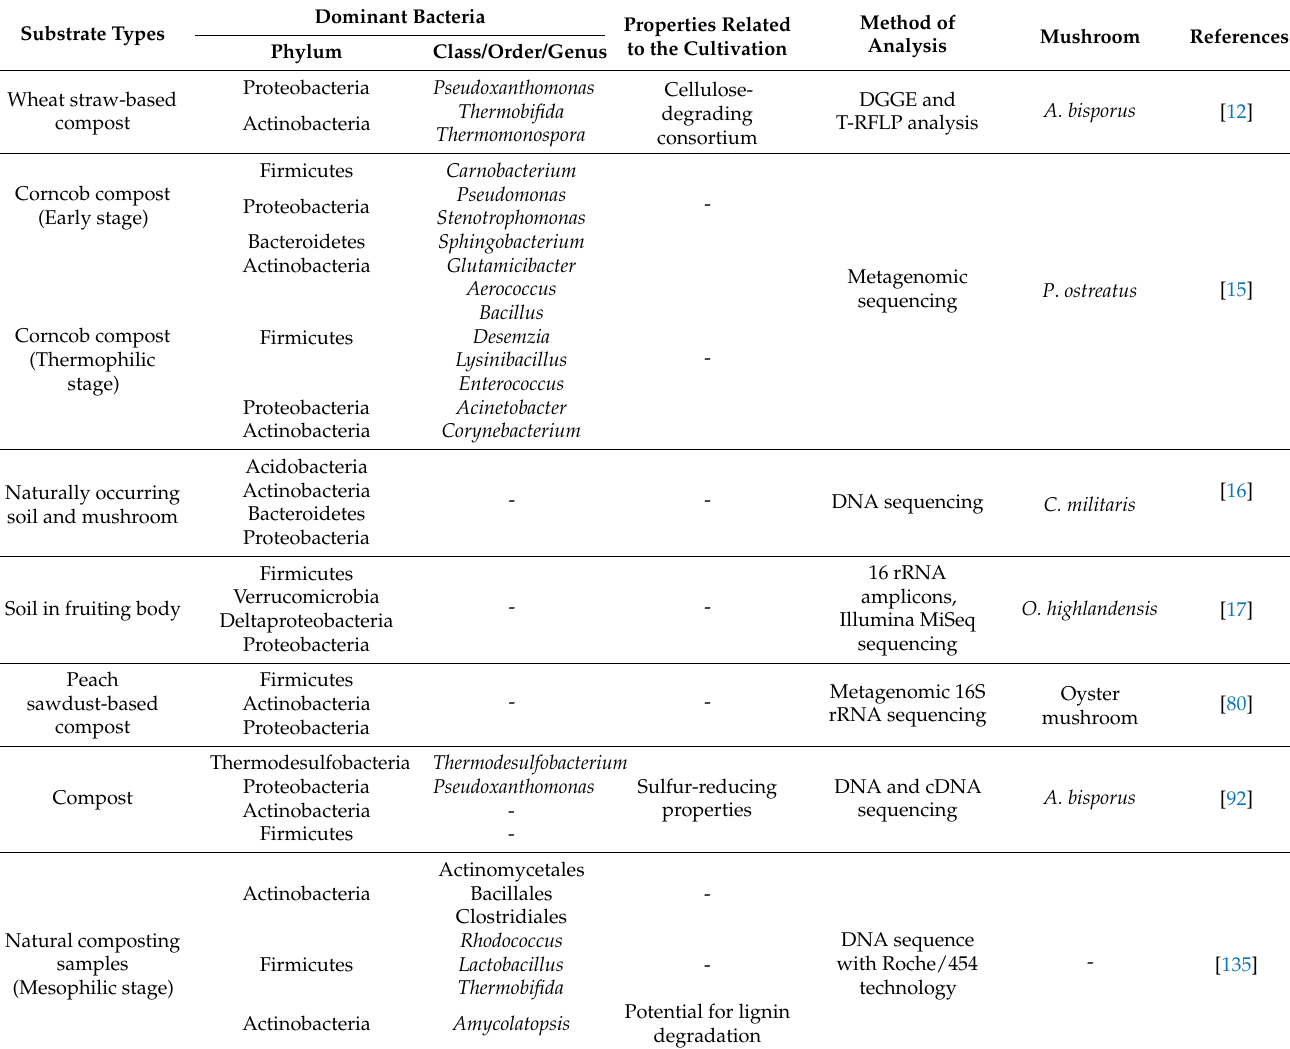
Table 2. Dominant bacterial communities in different types of